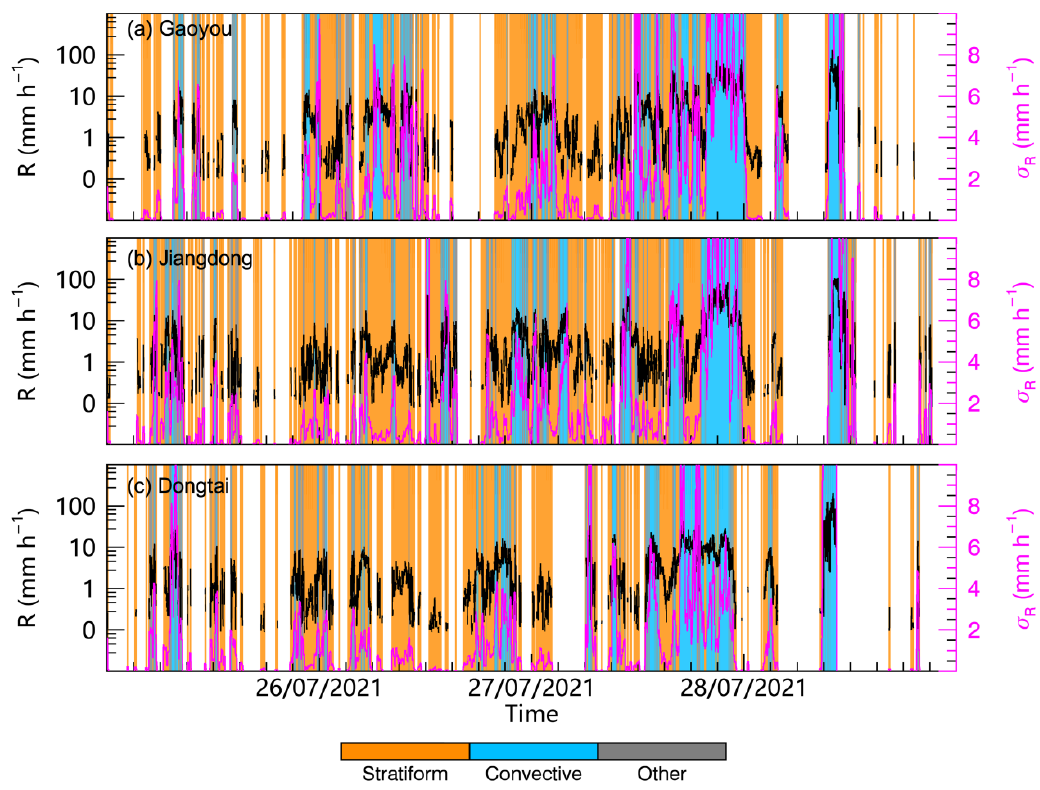
Figure 3. Time series of rain rate R (mm h − 1 ) and its standard deviation σ R (mm h − 1 ) measured by three disdrometers located in ( a ) Gaoyou, ( b ) Jiangdong, and ( c ) Dongtai respectively. The left ordinate (black color) denotes R while the right ordinate (magenta color) denotes σ R . The rain types are displayed in stripes of different colors. The precipitation collected by three disdrometers during Typhoon In-Fa landfall basically concentrated between 25 July 2021 and 29 July 2021.